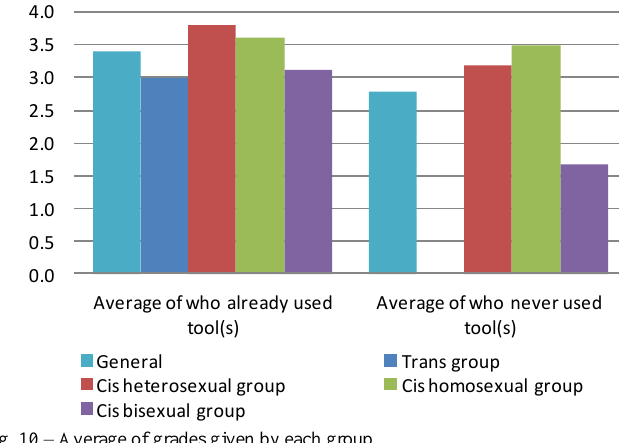
Fig. 10 – Average of grades given by each group